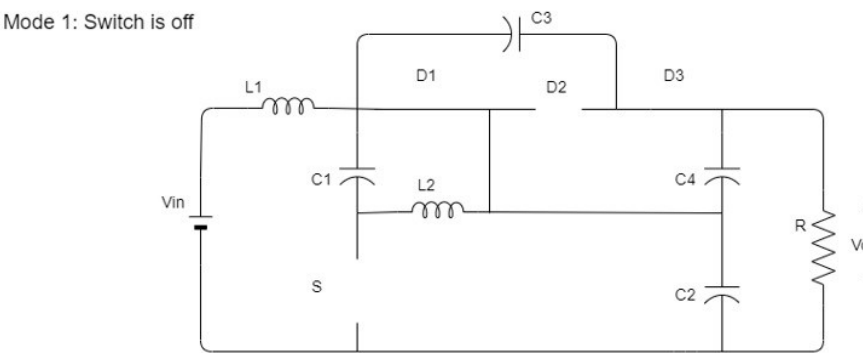
Figure 4. Topology of SCZEB converter [12].